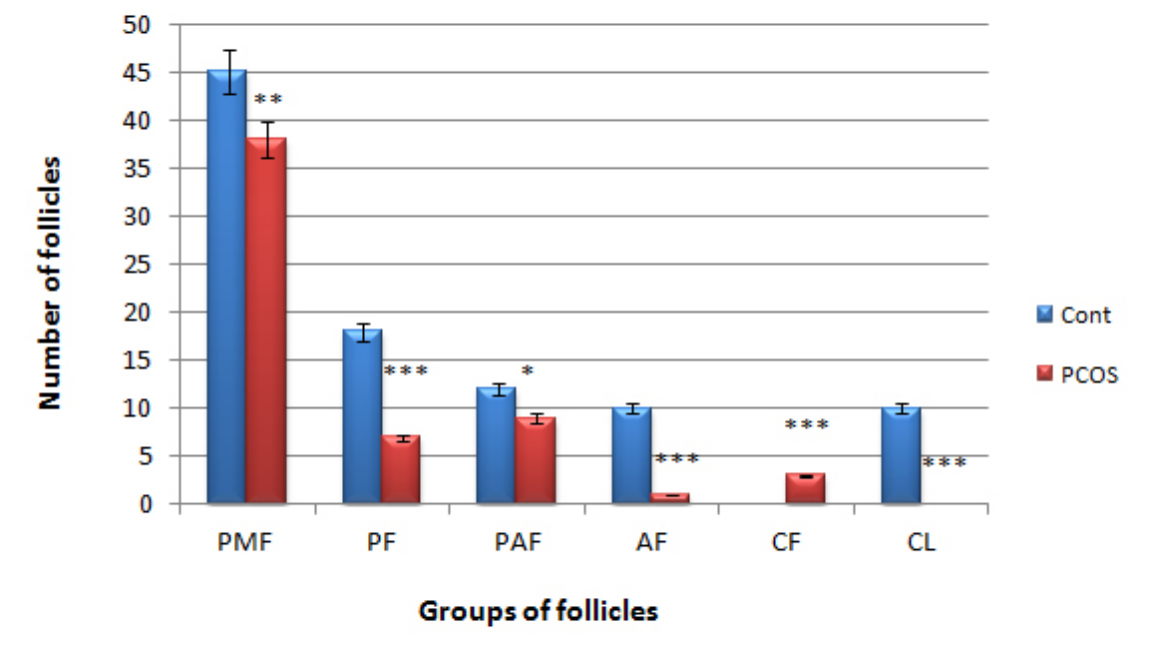
Figure 3. Different follicular groups in control and PCOS ovaries (n = 10). Note the increase in the numbers of cysts and a decrease in the number of corpora lutea of PCOS ovaries, respectively. PMF: primordial follicle; PF: primary follicle; PAF: preantral follicle, AF: antral follicle; CF: cystic follicle; CL: corpus luteum;